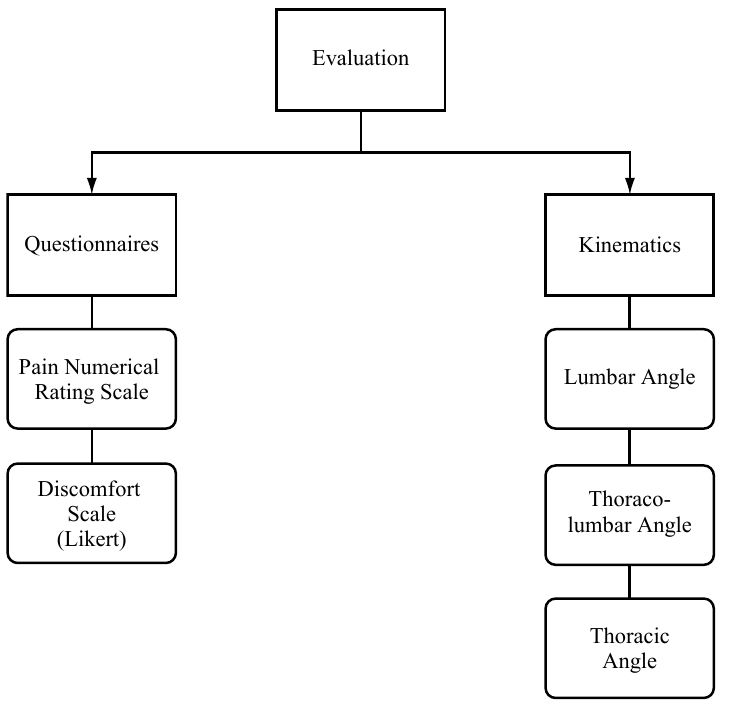
Figure 4 – Diagram of the trials evaluations by questionnaires and kinematic